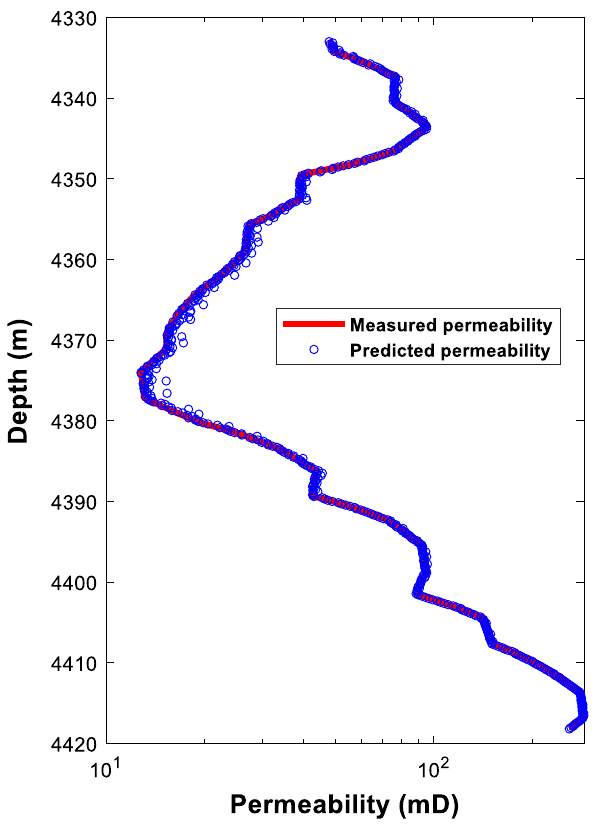
Fig. 15 Comparison of measured and predicted values of permeabil- ity for the MELM-COA model across the studied depth interval of well B (due to the wider range of permeability values in the interval under study, the vertical axis is considered logarithmically to provide a clearer presentation of the